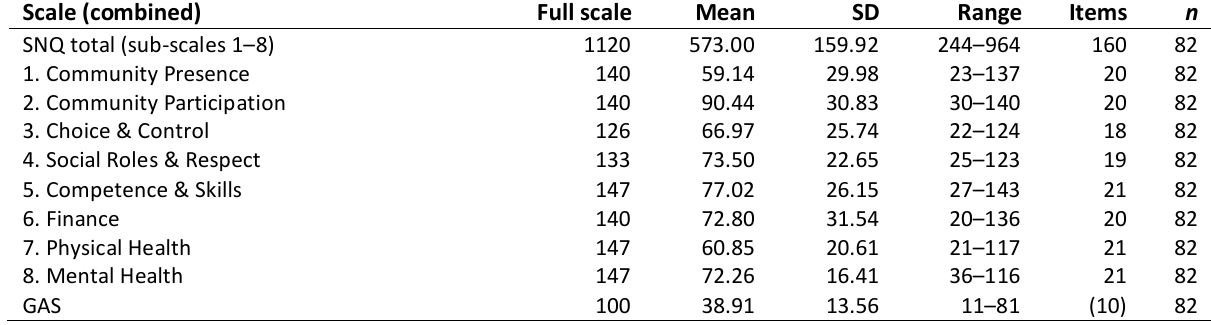
Table 3. Descriptive statistics for SNQ total, sub-scale scores and GAS ratings at T 1.